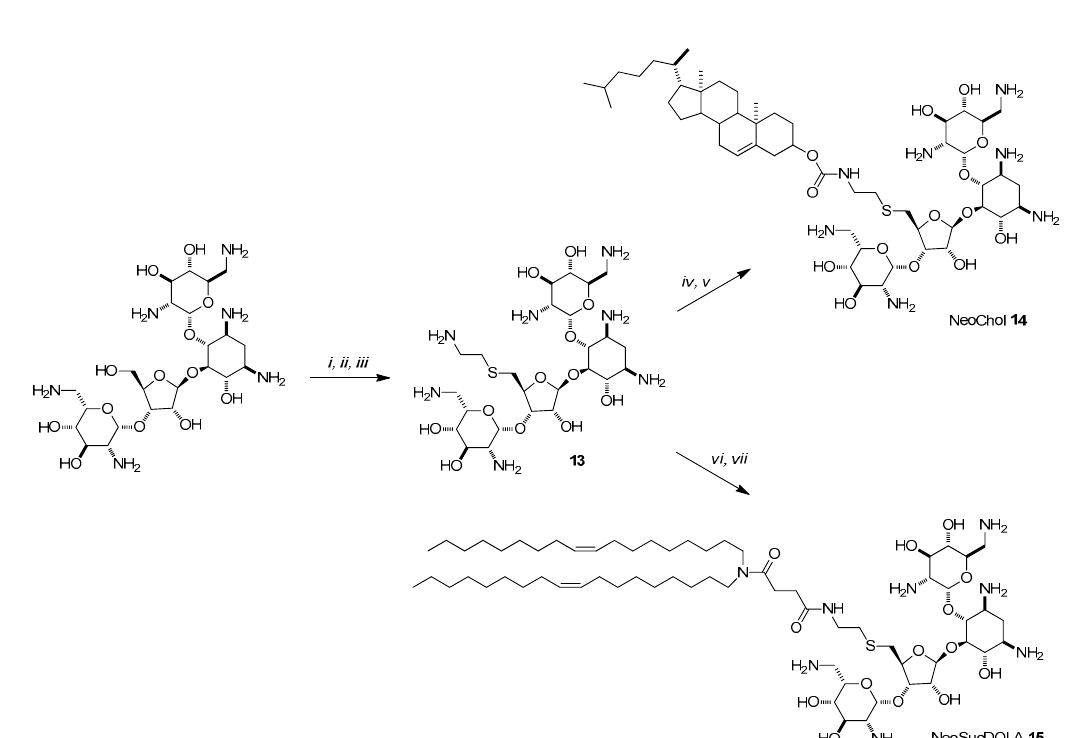
Figure 5. Structures of paromomycin-based lipids 9 – 12 .